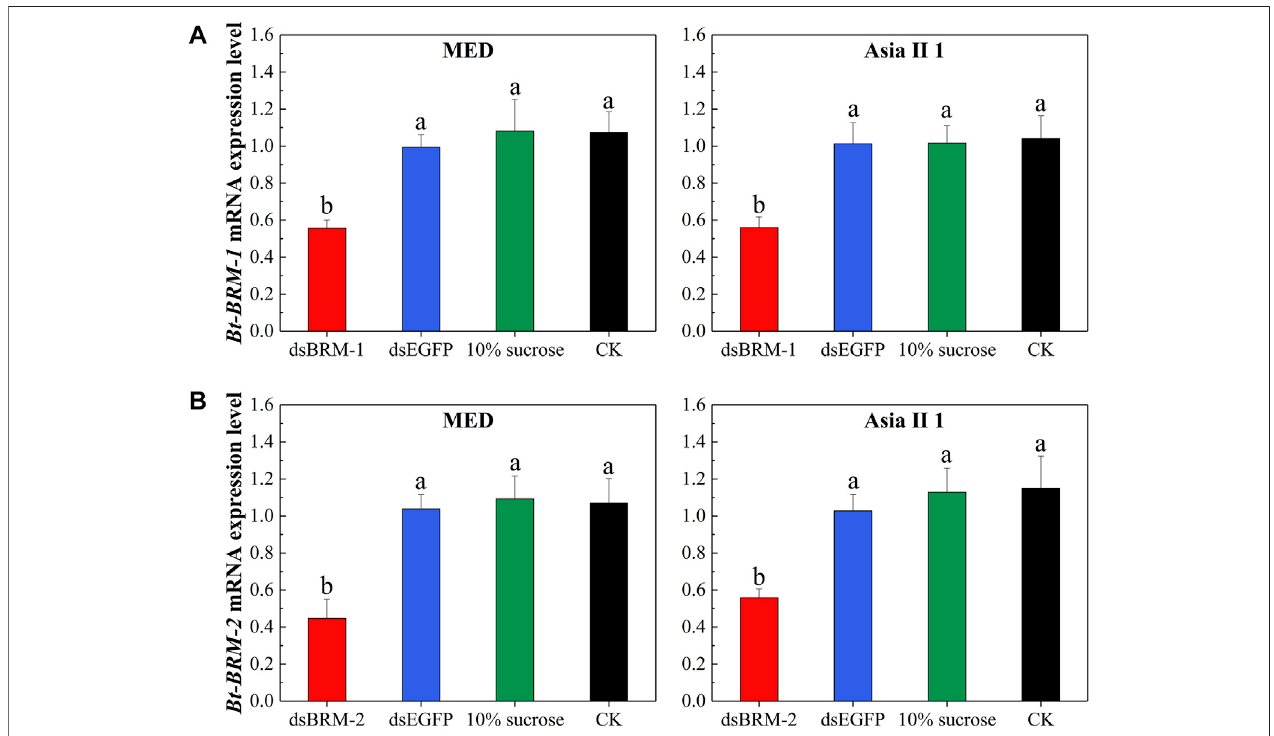
FIGURE 7 | Effect of double-stranded RNA (dsRNA) treatment on expression levels of Bt-BRM-1 (A) and Bt-BRM-2 (B) . The expression levels of target genes in MED and Asia II 1 after feeding with dsRNA for 3 h were signi fi cantly decreased compared with the controls: white fl ies untreated (CK), fed EGFP dsRNA (dsEGFP), or given 10% sucrose. The expression levels are expressed as the mean ± SE. Bars with different lowercase letters are signi fi cantly different at p < 0.05.